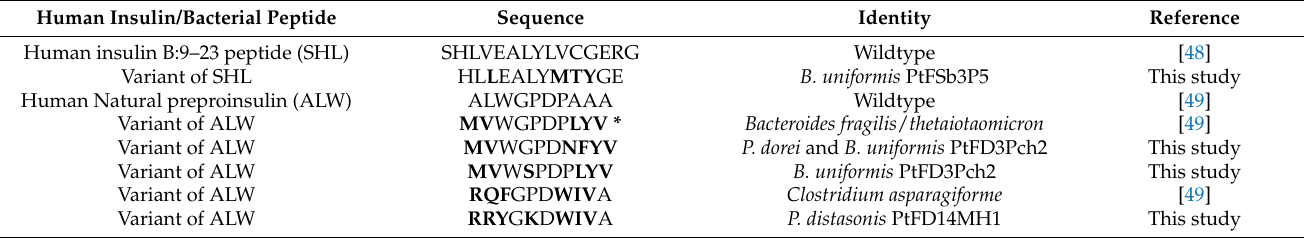
* Bold letters represent amino acids that are different from the reference preproinsulin-derived